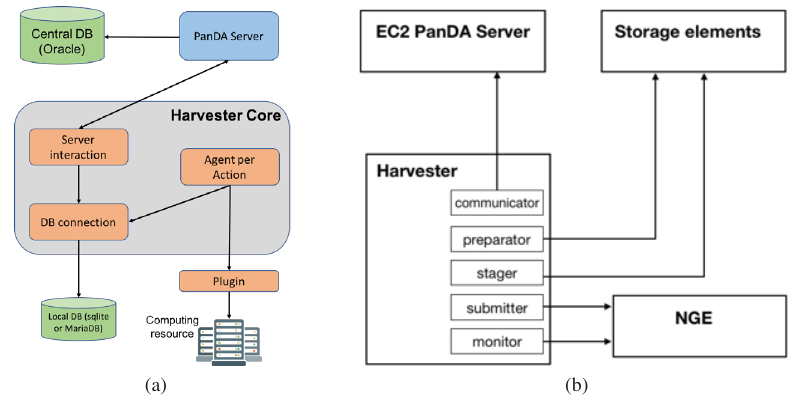
Figure 1: (a) Harvester architecture; (b) Modules used for PanDA-NGE